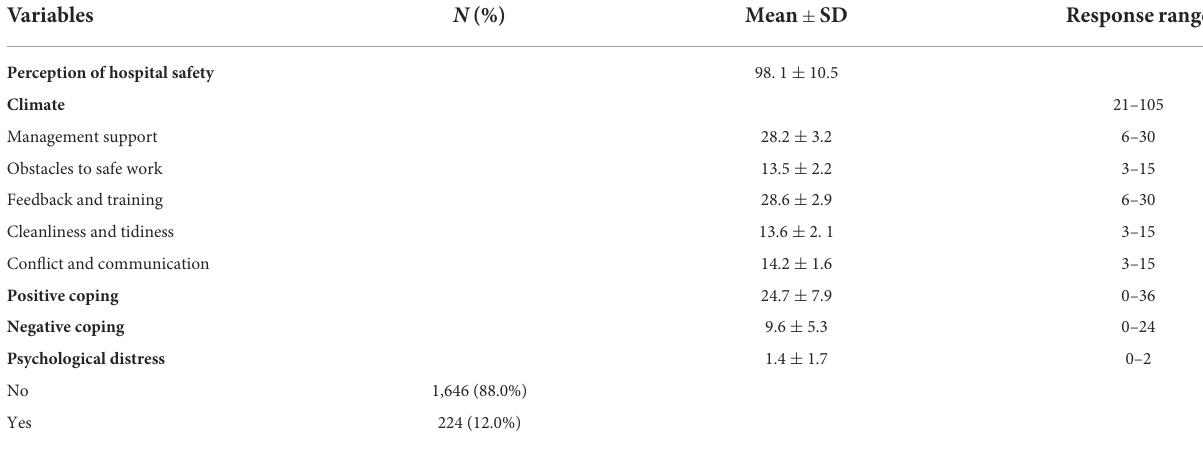
TABLE 2 Scores of the PHSCS and SCSQ, and percentages of psychological